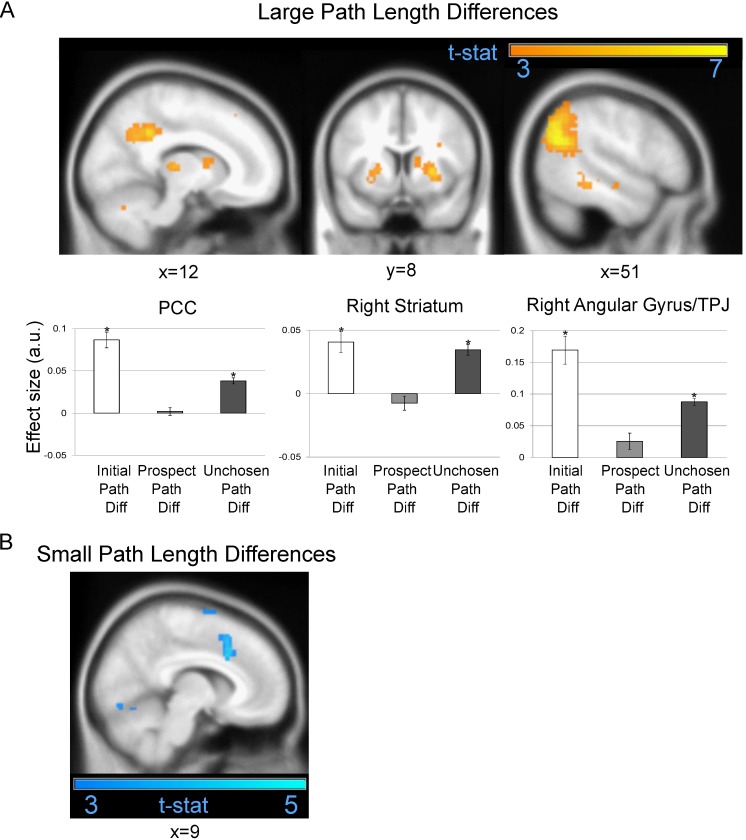
fMRI activations related to unchosen path length difference.(A) Regions that significantly responded to larger unchosen path length differences between the shortest and unchosen path. Top left: Sagittal image showing posterior PCC. Top centre: Coronal image showing right striatum. Top right: Sagittal image showing right angular gyrus. Bottom: Effect size for an 8-mm sphere around the PCC (left), right striatum (centre), and right angular gyrus (right) regions that responded to larger unchosen length differences displayed in A, for three parametric modulators: initial (deep and shallow mazes), prospective, and unchosen path length differences (mean ± SEM). Asterisks indicate a significant correlation (p < 0.05) with path length differences. A positive effect size represents a positive BOLD correlation with larger path length differences, whereas a negative effect size represents a correlation with smaller path length differences. (B) dACC region significantly responding to smaller unchosen path length differences. All highlighted regions survived cluster-level FWE correction at p < 0.05 and are displayed at an uncorrected statistical threshold of p < 0.005. See S3 Data for individual effect sizes.